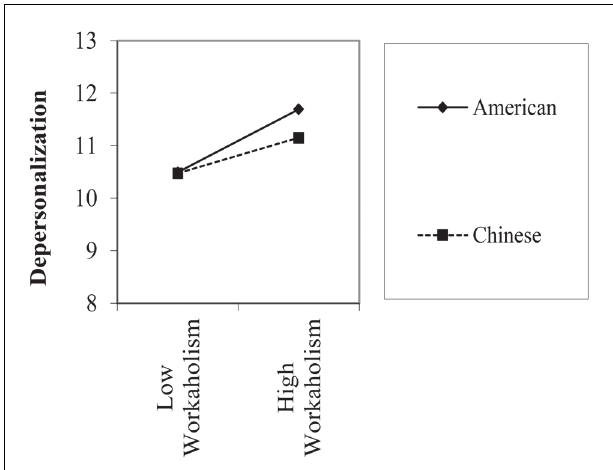
FIGURE 1 | Moderated regression analysis predicting depersonalization among participants in manufacturing industry.